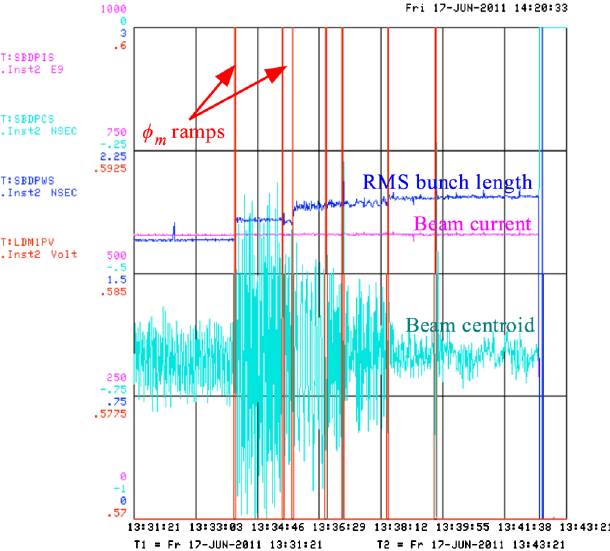
FIG. 9. The beam is modulated 7 times using the (cid:2) m ramp shown in Fig. 4 at 980 GeV. After the seventh modulation the dancing stops but there is growth in the rms bunch length because of the shape change.